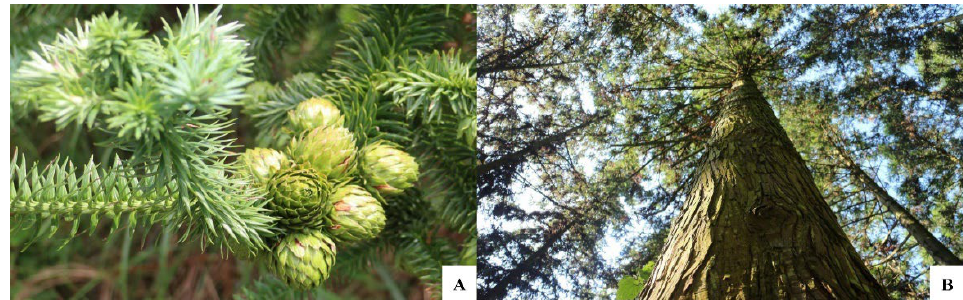
Figure 1. ( A ) Twigs and cones of Chinese fir. ( B ) Trunks and tree canopies of Chinese fir.